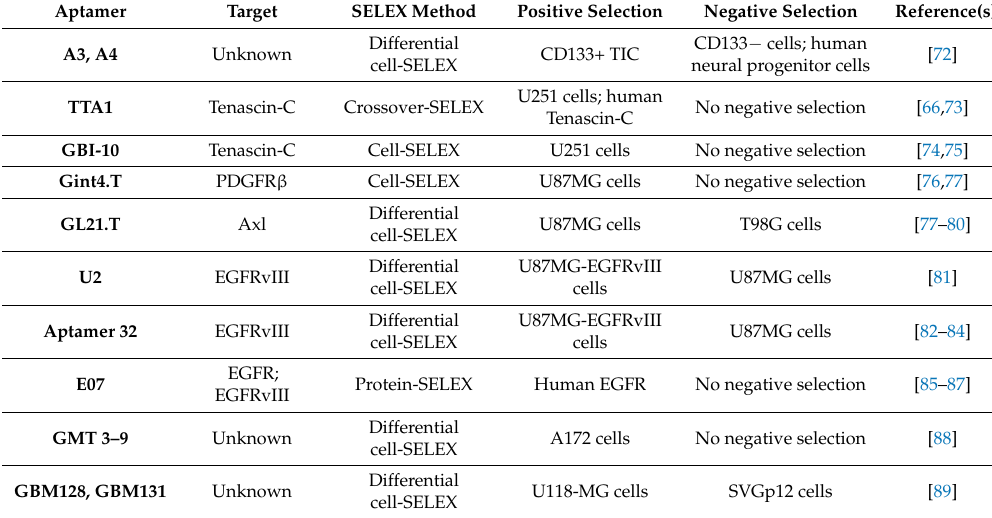
Table 1. Glioblastoma aptamers and their SELEX